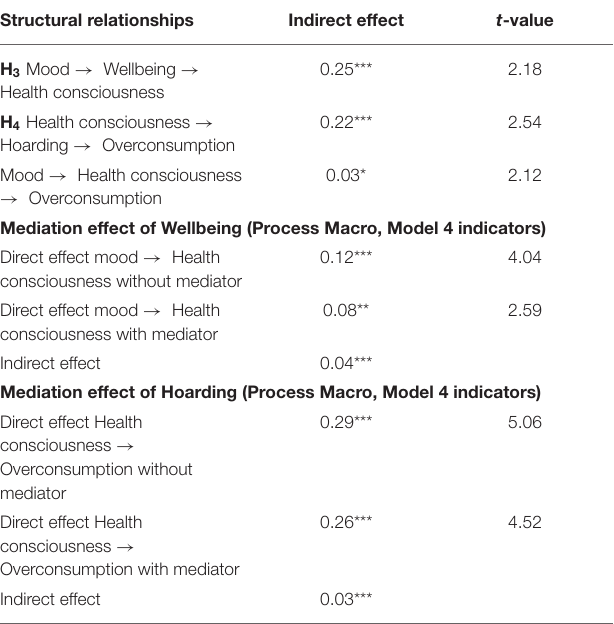
TABLE 5 | Mediation analysis